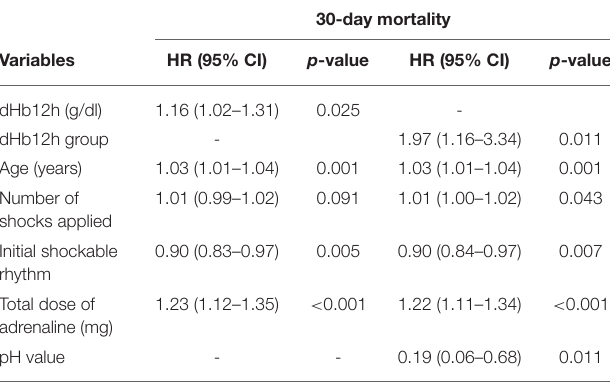
TABLE 4 | Multivariable analysis of the secondary endpoint.